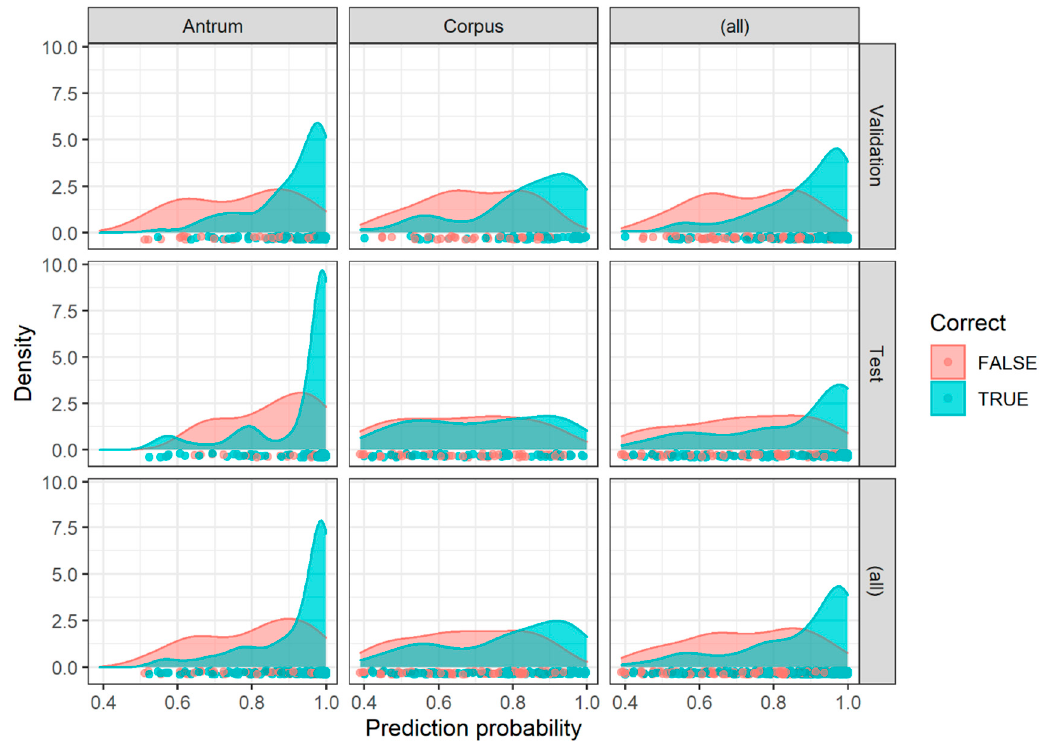
Figure 5. Classification result according to the prediction probability. The classification results (correct yes versus not) of image patches from the antrum validation set, corpus validation set, antrum test set, and corpus test set are shown according to their prediction probability along with marginal summaries